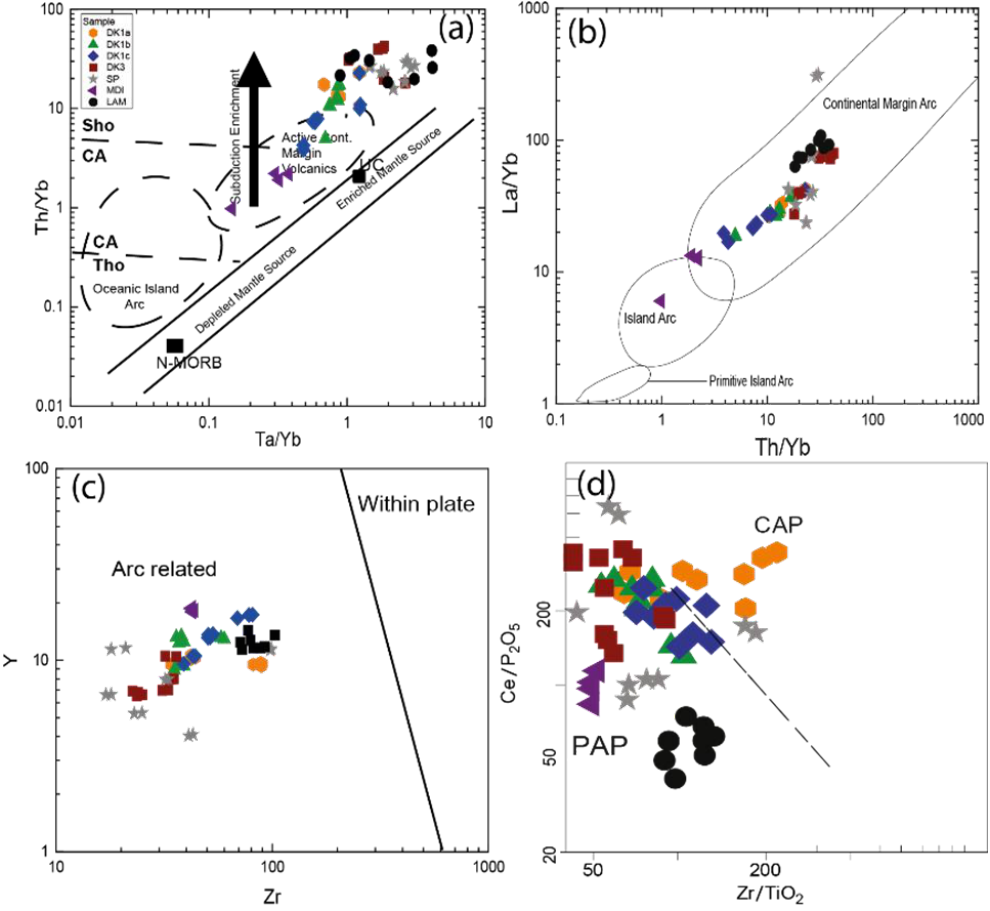
Figure 15. ( a ) Th/Yb vs. Ta/Yb diagram [52] for the Sungun post mineralization dykes. Tho is tholeiitic, CA is calc-alkaline, Sho is shoshonitic; ( b ) La/Yb vs. Th/Yb geotectonic discrimination diagram after [53]. The sungun stock and late dykes plot in the Continental Margin Arc fields; ( c ) Y vs. Zr geotectonic discrimination diagrams of [47], for within-plate and from arc related and ( d ) Ce/P 2 O 5 vs. Zr/TiO 2 geotectonic discrimination diagrams of Reference [47], samples plot mostly in the PAP field. PAP is post collision arc and CAP is active continental margin.